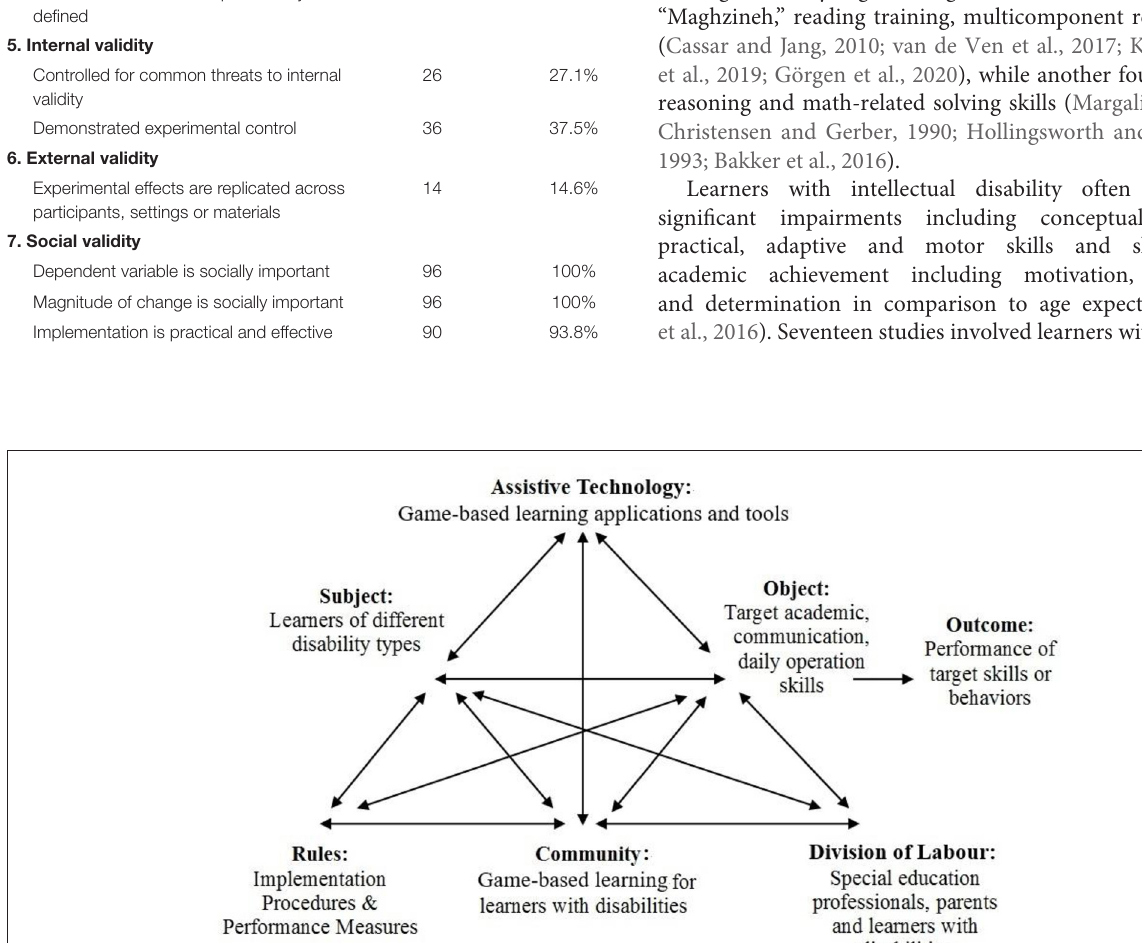
Frontiers in Psychology |